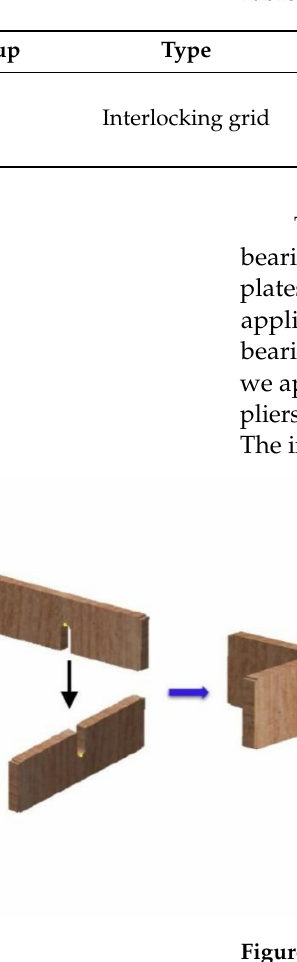
Table 3. Parameters of interlocked grid structure specimens.